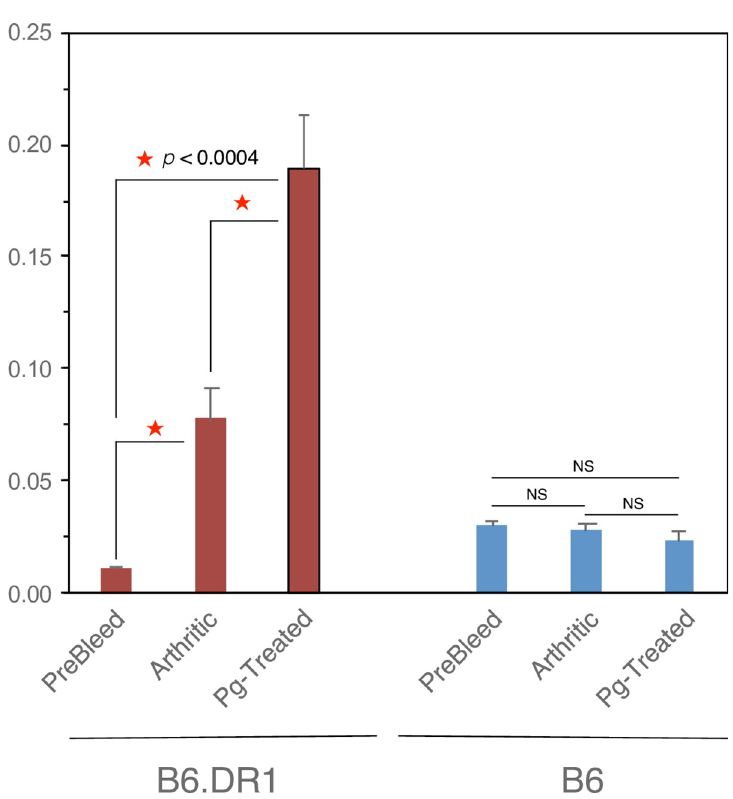
Fig 3. The presence of the shared epitope drives an enhanced production of ACPAs as a result of autoimmune arthritis induction or after inoculation with P . gingivalis . Serum from B6.DR1 or WT B6 mice was applied to commercial diagnostic ACPA ELISA by substitution of the 2˚ antibody as described in the Materials and Methods section. Histograms indicate ACPA levels in serum from mice subjected to either collagen induced arthritis experiments (Arthritic) or those repeatedly inoculated with P . gingivalis as indicated. � p < 0.0004 by t